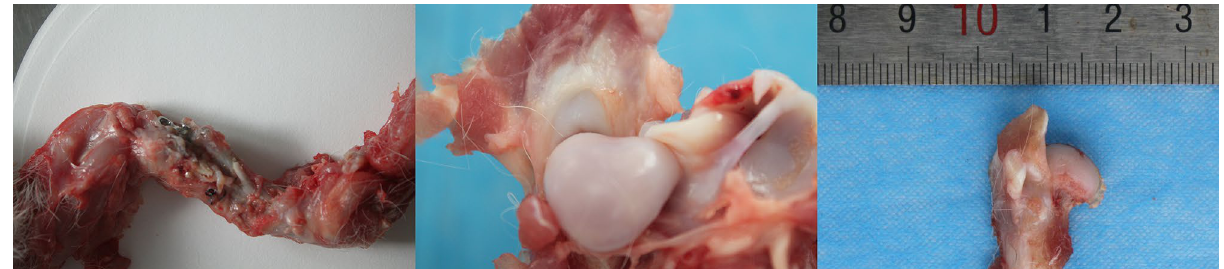
Figure 3. Specimens of the shoulder complex and proximal humerus with subscapularis